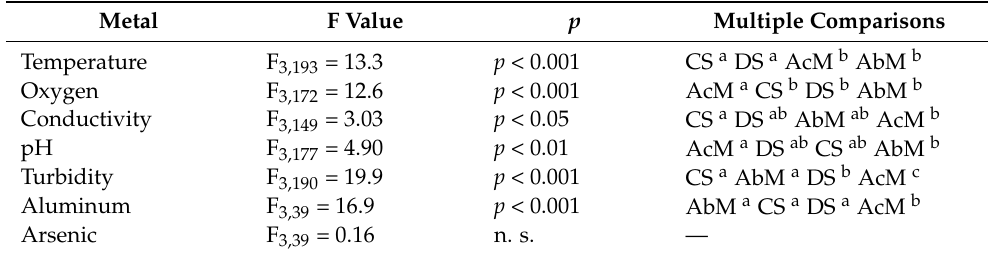
Table A2. Results of one-way ANOVA (location) and multiple comparisons with Tukey’s test of physical and chemical variables and heavy metal concentrations at the study sites (CS, control sites; AcM, active mines; AbM, abandoned mines; DS, downstream sites; n. s., not significant). There are no significant differences between locations with the same